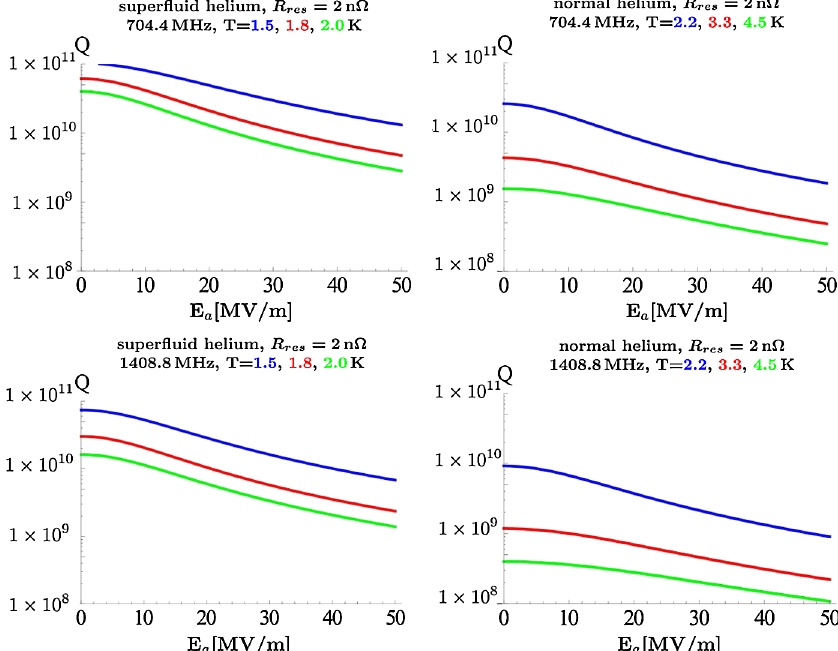
FIG. 6. (Color) Real performance of SPL-type (cid:1) ¼ 1 superconducting cavities, as summarized by Eq. (5), at different frequencies, 704.4 MHz (top) and 1408.8 MHz (bottom), and several bath temperatures for cooling with superfluid helium (left) and normal boiling helium